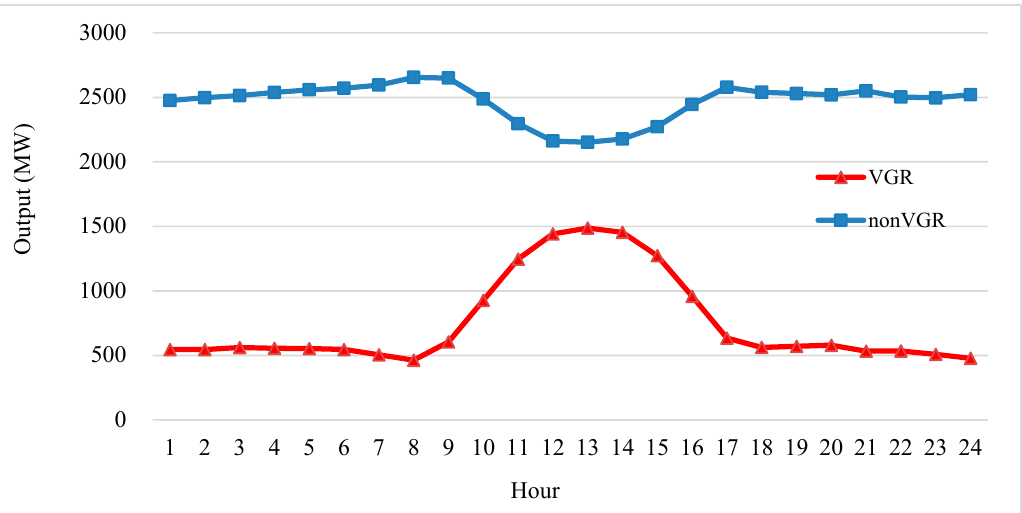
Figure 3. Output profiles of the selected VGRs (i.e., wind and PV systems) and non-VGRs for the peak-load day.